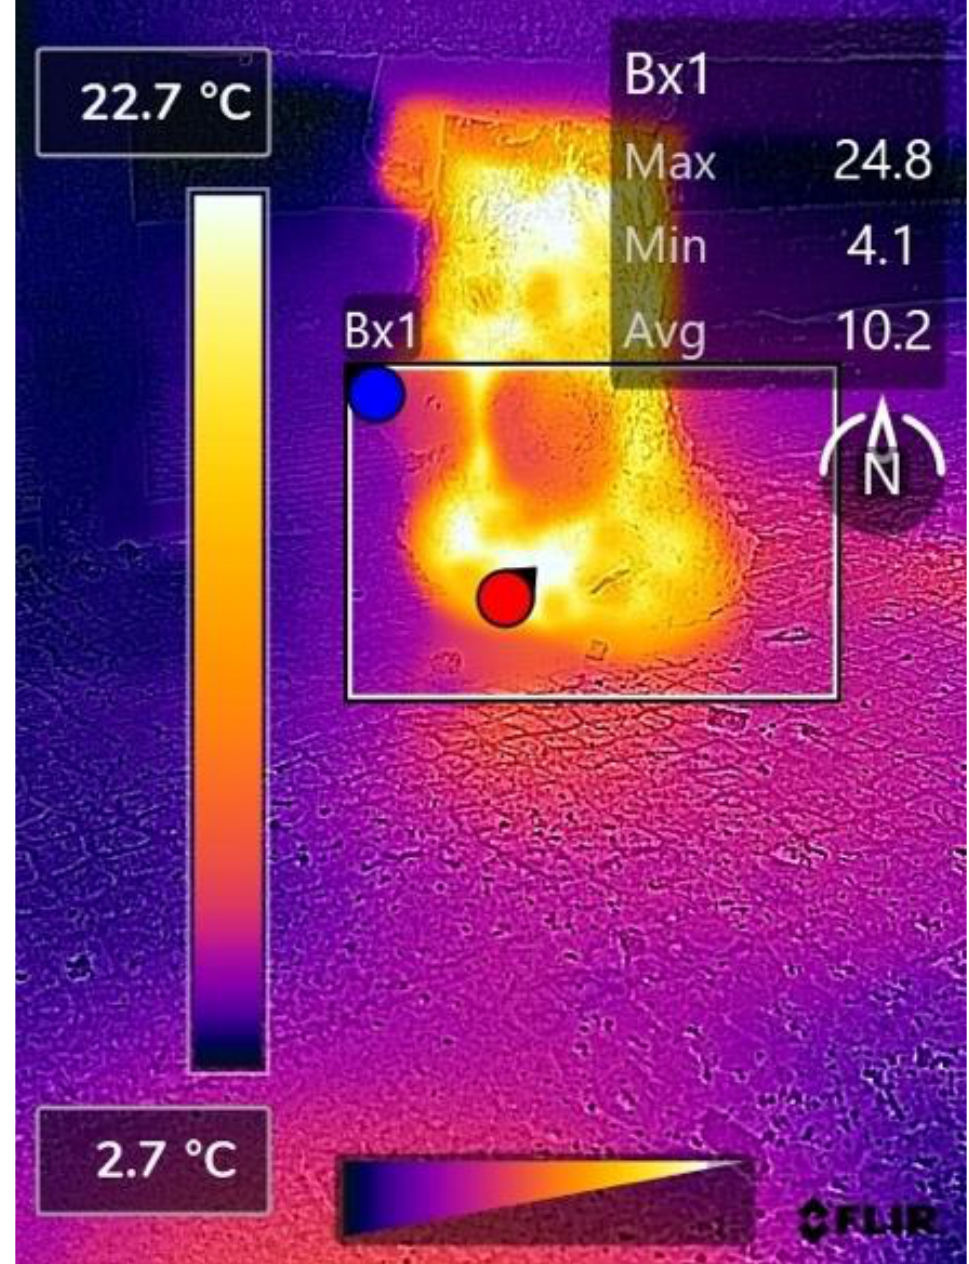
Figure A5. A thermogram, obtained by the CAT s62-Pro Smartphone (LCD), of cattle diagnosed with digital dermatitis on routine foot trimming, displaying a pattern of heat with maximum intensity over the interdigital space, rather than between the heel bulbs.